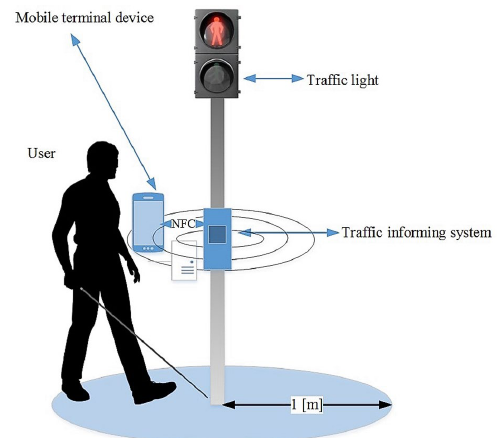
Fig. 5. Informing users using NFC technology and mobile terminal device